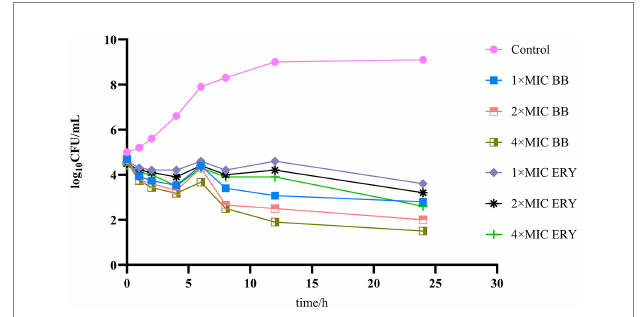
FIGURE 2 The time-kill curves of drugs on SEP-05. BB, Disaspidin BB. ERY, erythromycin.